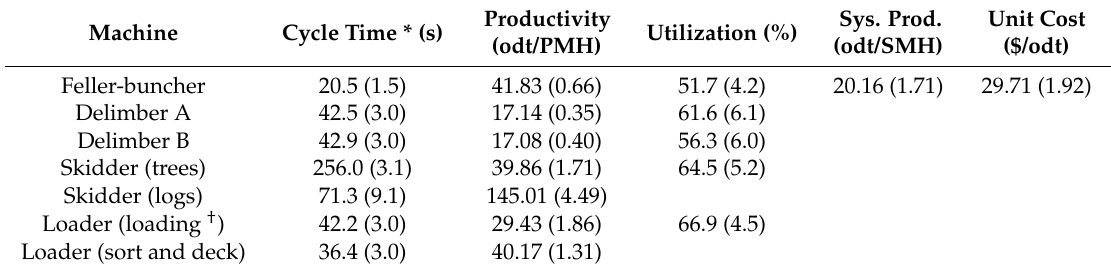
Table 4. Performance metrics of individual machines and the entire system of whole-tree harvesting generated by 100 simulation runs of the DES model. Standard deviations are shown inside parentheses.